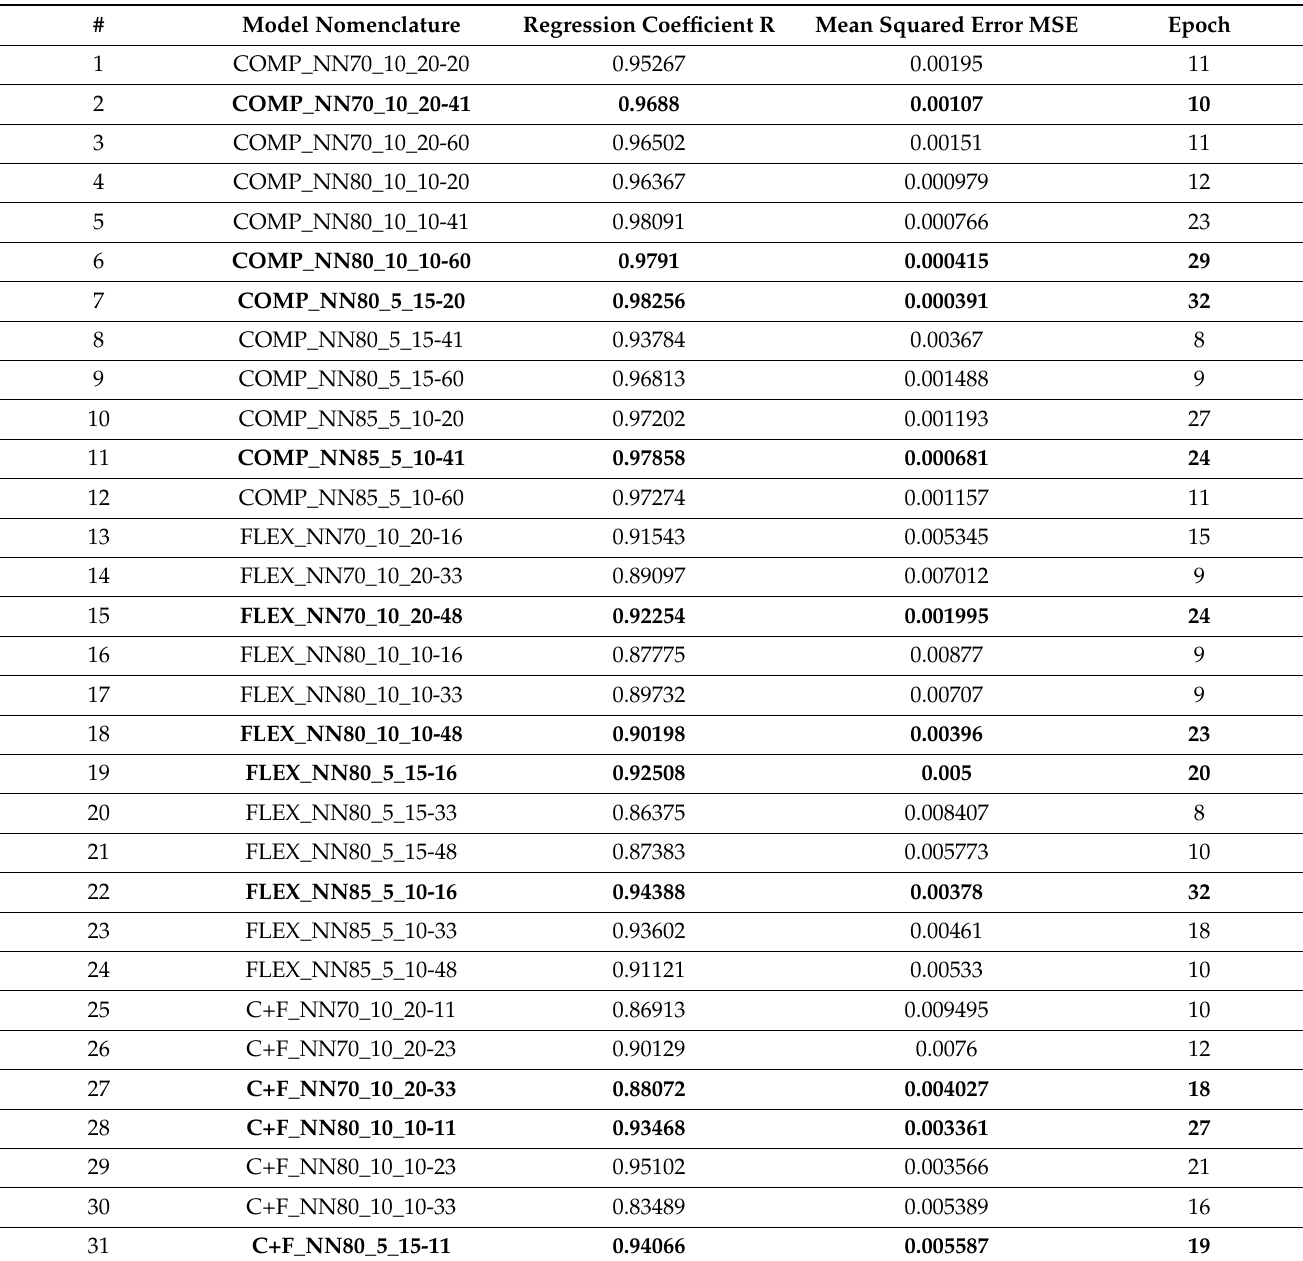
Table 7. Response values of ANN